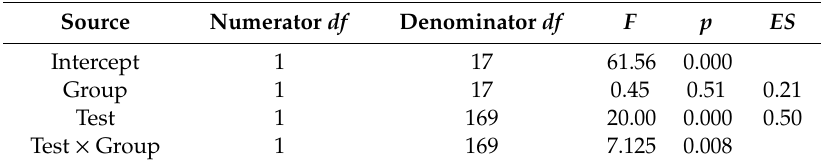
Table 2. Results of the linear mixed model of gaze behavior. Dependent variable: total gaze duration. Table 3. Total gaze duration (seconds) per shot (mean values), F -values, degrees of freedom (df ), p - F -values, p -values, degrees of freedom ( df ), and e ff ect sizes ( ES ) for main e ff ects (group: CG vs. VG; values, and size effects ( ES ) for pairwise comparisons of CG and VG in pre- and posttests. test: pretest vs. posttest) and interaction (test ×